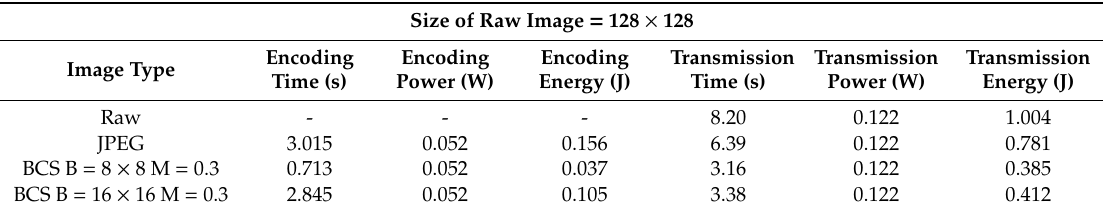
Table 6. Comparison of computational complexity and energy consumption with and without using